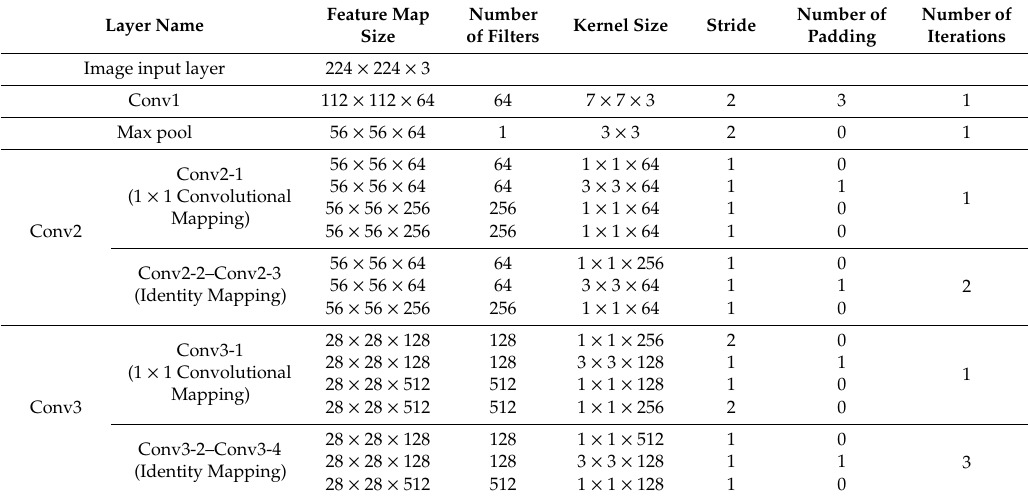
Layer configuration details of our deep residual convolutional neural network (CNN)